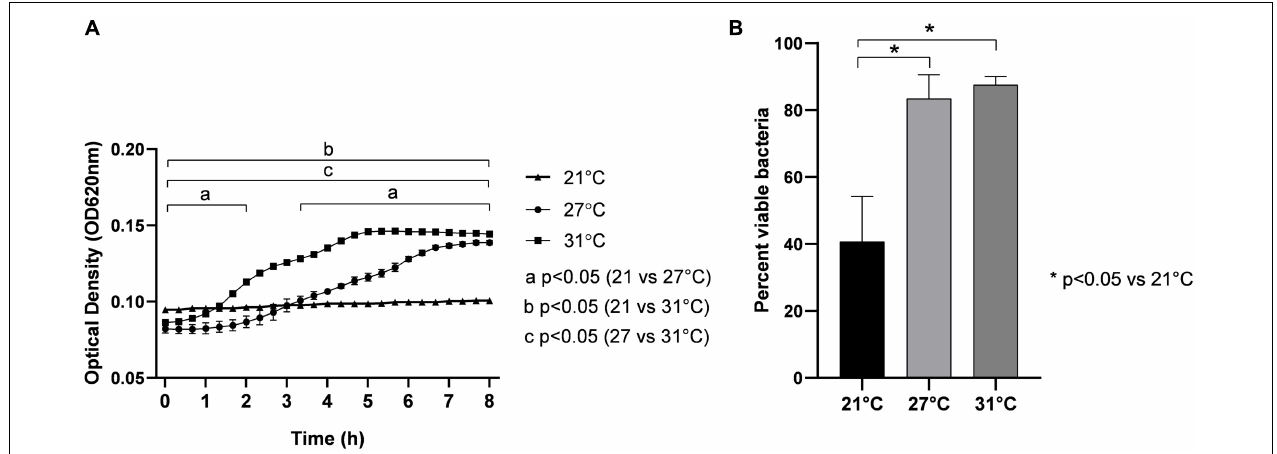
FIGURE 1 | Effect of temperature on growth by optical density measurement at 620 nm (OD 620 ) (A) and viability (B) of V. parahaemolyticus maintained in seawater at different temperatures: 21, 27, and 31 ◦ C. Bacteria were seeded in FSW at OD 620 ∼ 0.1, corresponding to 3.4 × 10 7 CFU/ml. Results are expressed as means ± standard deviations from experiments performed with three replicate